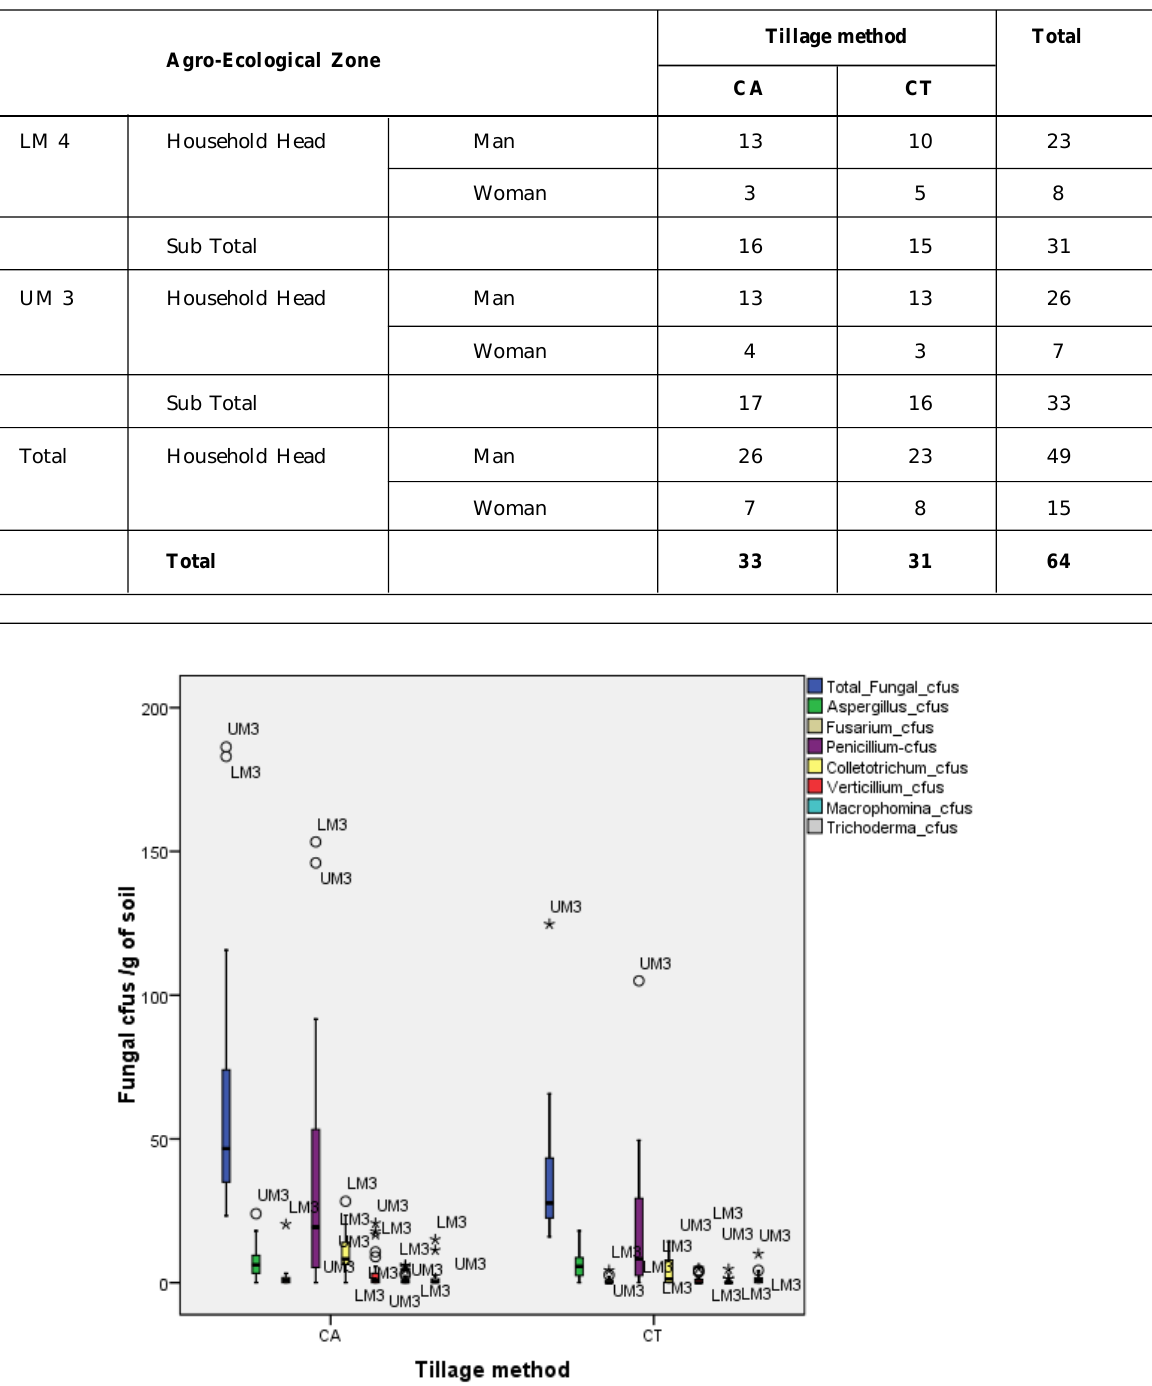
Table 1: Trial collaborating farmers by gender of household head